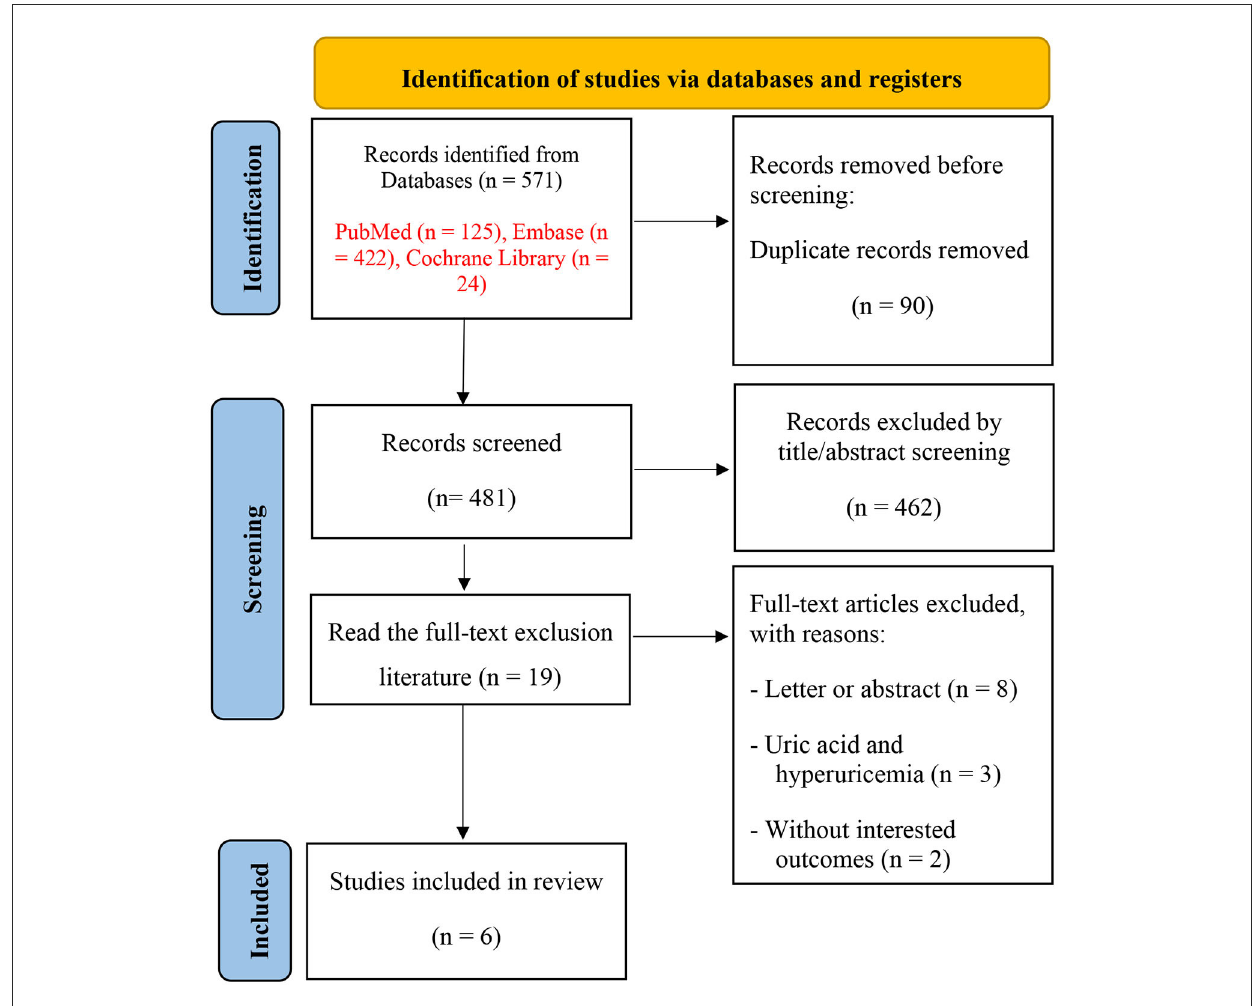
FIGURE1 Literature screening